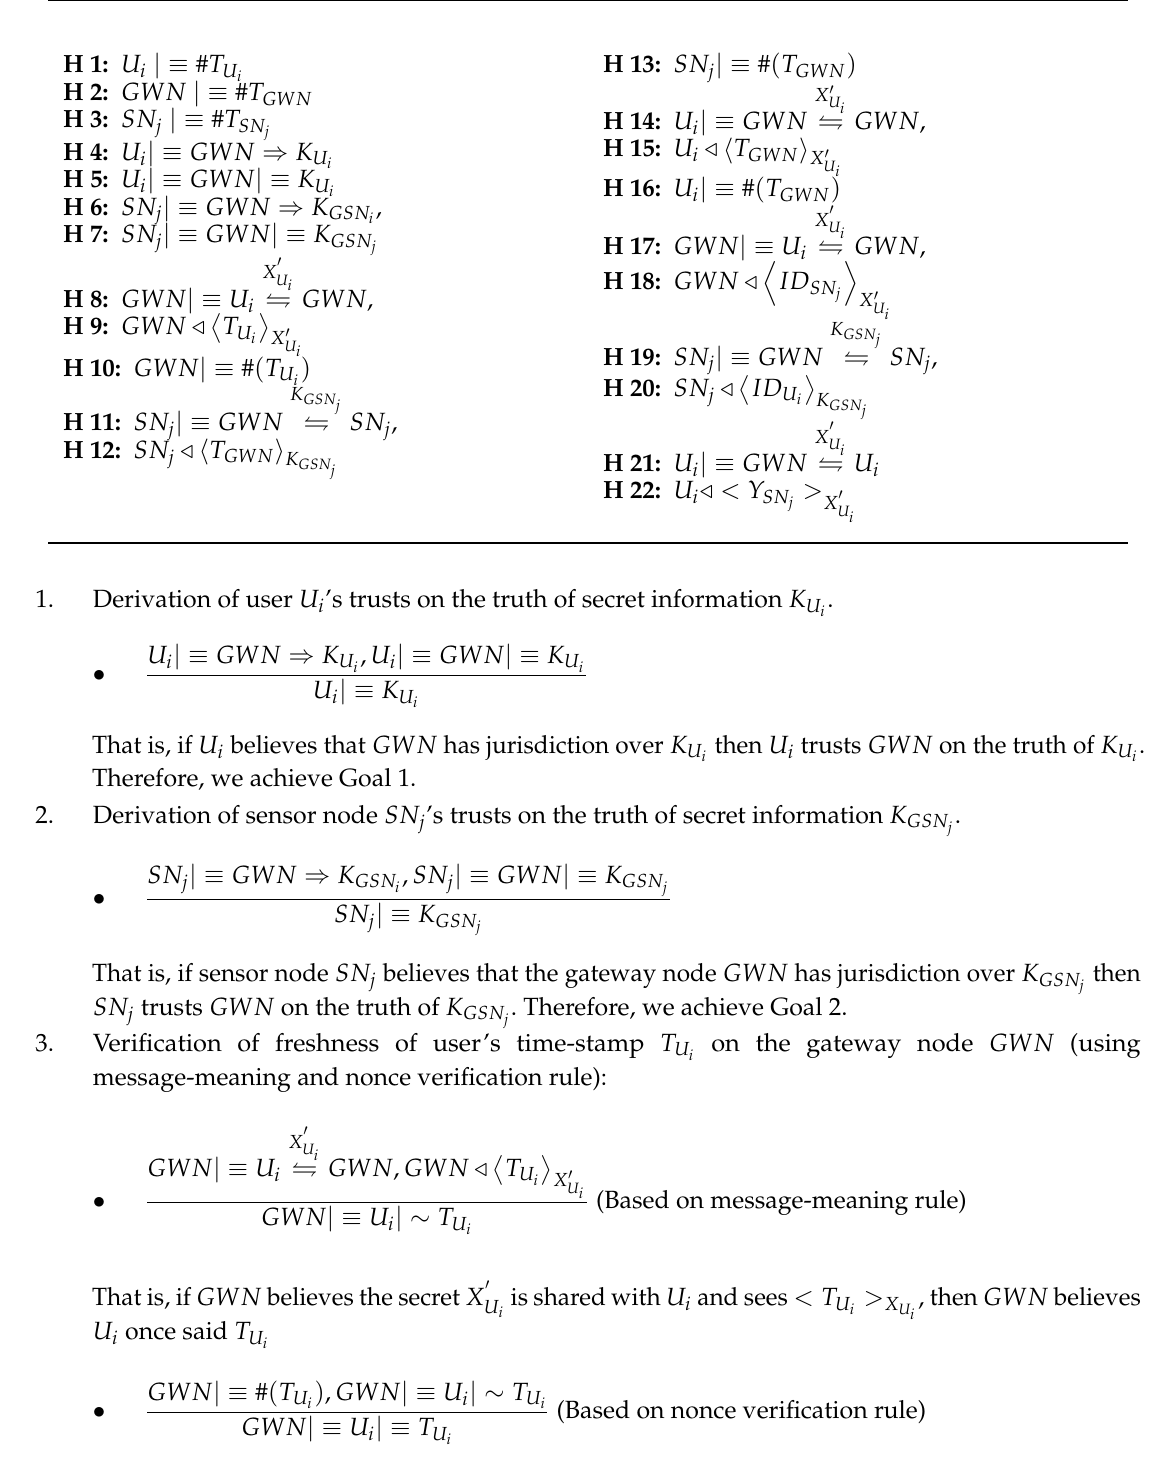
Table 23. Hypotheses: The assumptions made to analyze the proposed